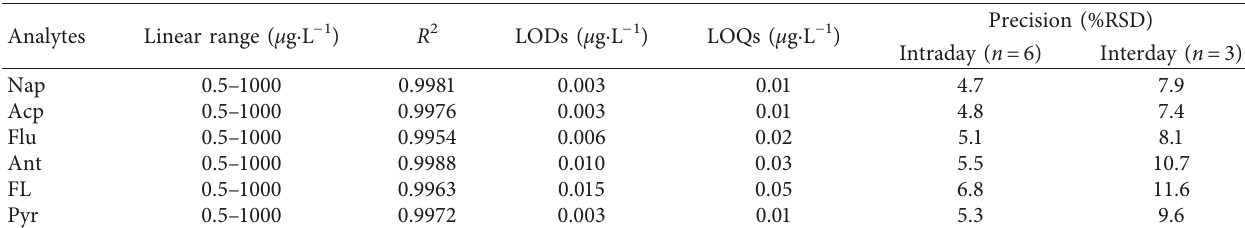
Table 3: Comparison of the proposed method with other preconcentration methods for determination of PAHs in water. Preconcentration technique